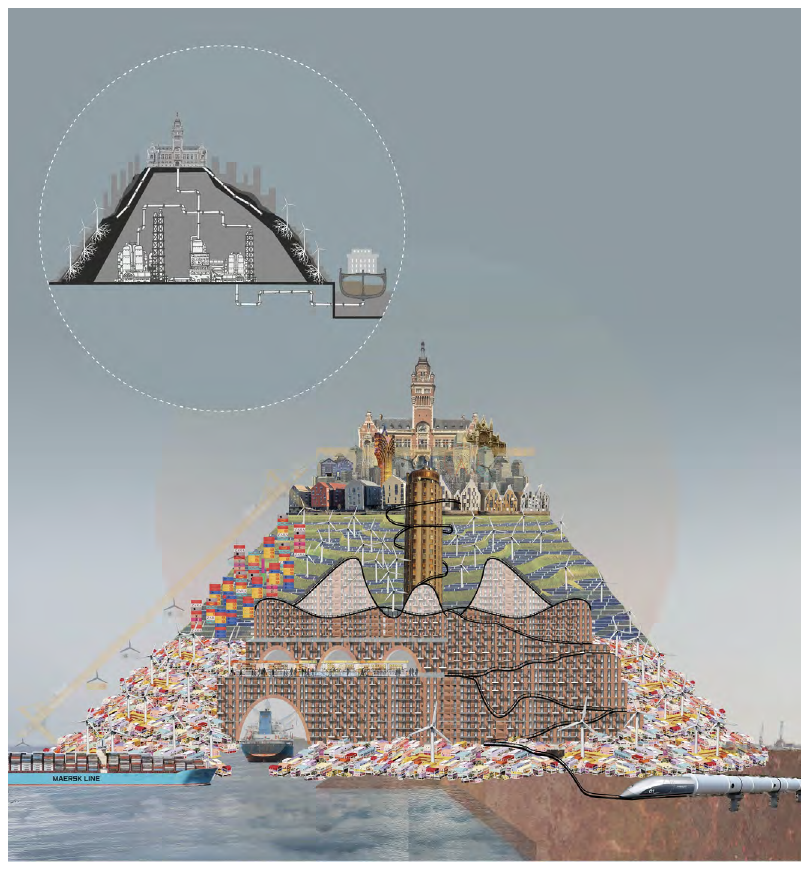
Example of a scenario beyond oil: design fiction for port and city of Dunkirk. ©Rashid